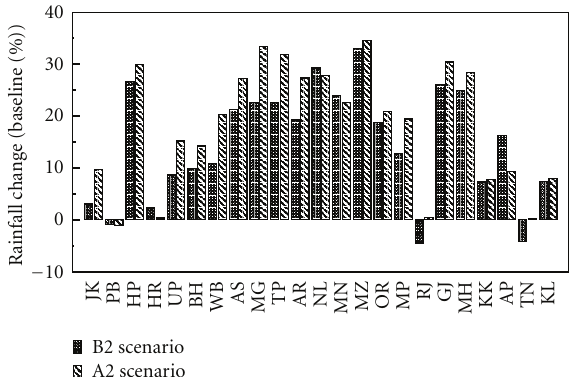
Figure 7: Statewise changes in seasonal precipitation in A2 and B2 scenarios (2071–2100) in terms of percentage of baseline (1961–